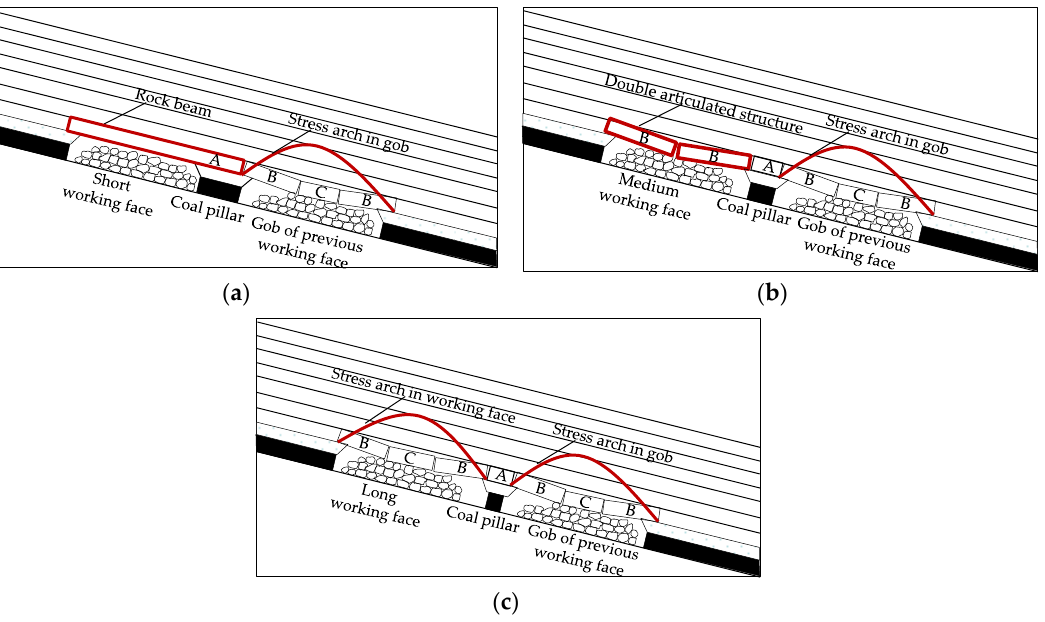
Figure 1. Inclined fracture structure of thick and hard roof in working face. ( a ) Rock beam—multi articulated stress arch structure; ( b ) double articulated ‐ multi articulated stress arch structure; ( c ) multi ‐ articulated stress arch—multi articulated stress arch structure.